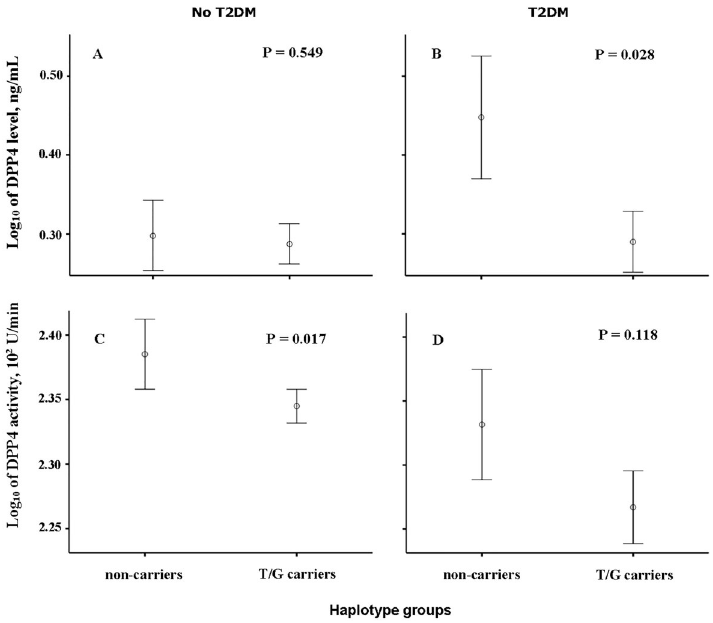
Figure 1. Comparison of log-transformed circulating levels ( A and B ) and log-transformed serum activity ( C and D ) of dipeptidyl peptidase 4 (DPP4) between carriers and non-carriers of the T/G haplotype of the gene, with individuals grouped according to a clinical diagnosis of type 2 diabetes mellitus (T2DM). Signi fi cance was veri fi ed by ANCOVA with adjustment for waist circumference and intake of antihypertensive agents ( A and C ) and for consumption of antidiabetic drugs ( B and D ). Data are reported as means and vertical bars represent intervals of one standard